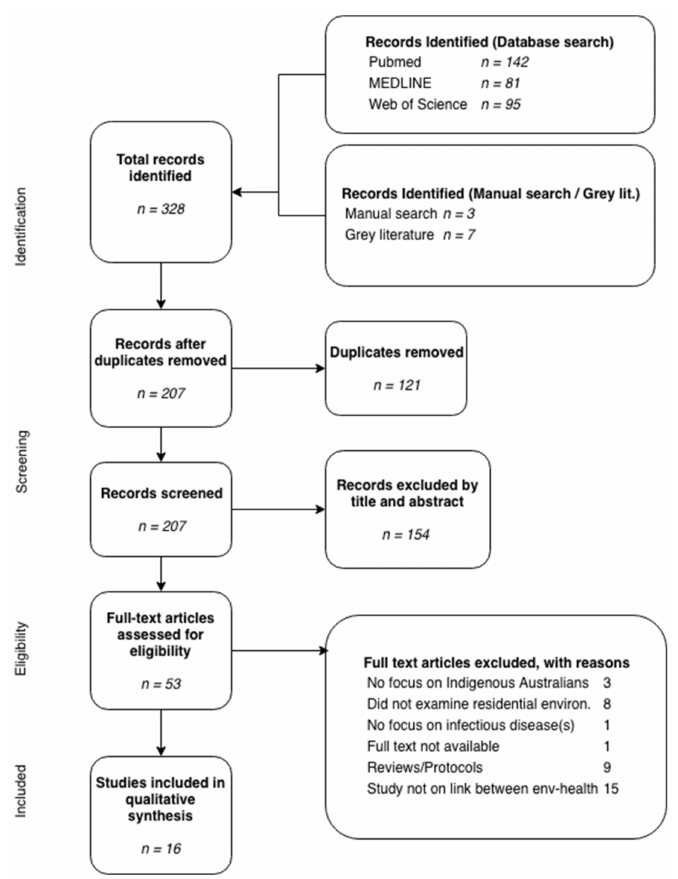
Figure 1. PRISMA flow-chart of search strategy and